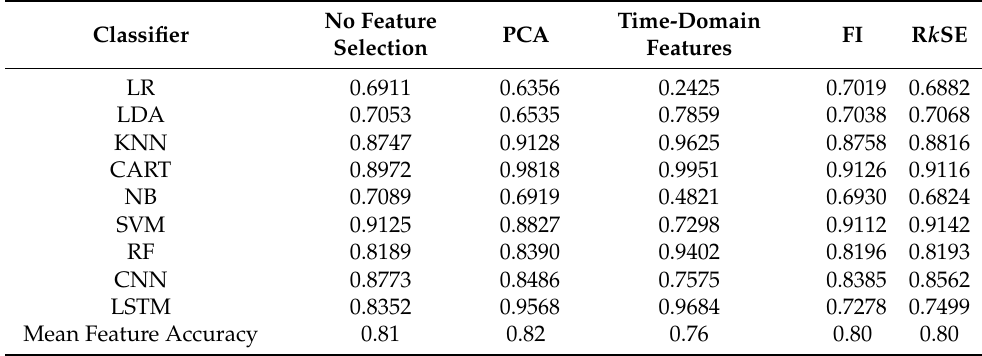
Table 4. Classification Accuracy for Different ML and DL approaches using various Feature Engi- neering